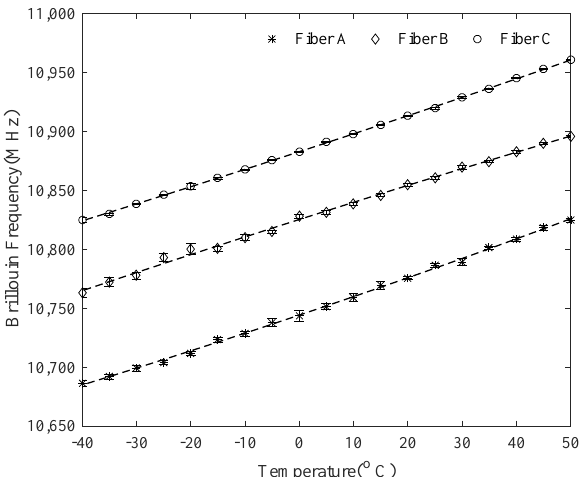
Figure 6. Brillouin frequency-shift variation with the temperature of different fibers glued on the same rail.